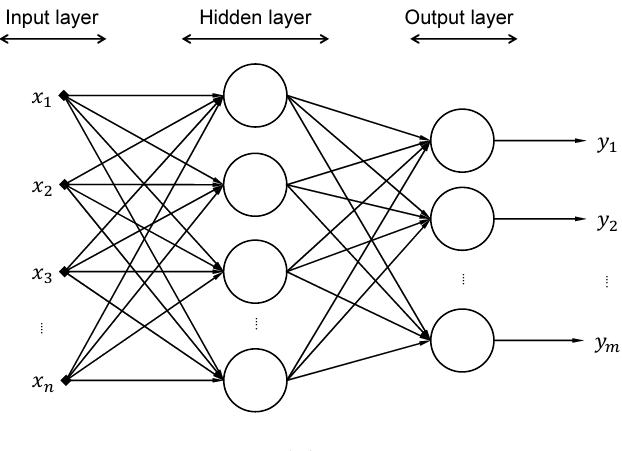
Figure 2. Multilayer